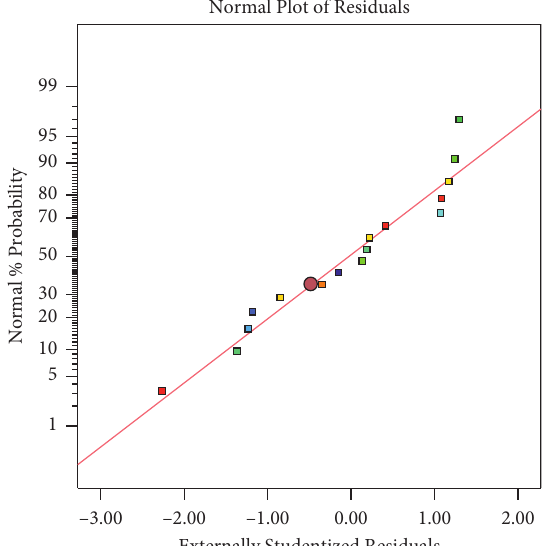
Figure 5: Normal probability plots of residuals for the adsorption capacity of MX.